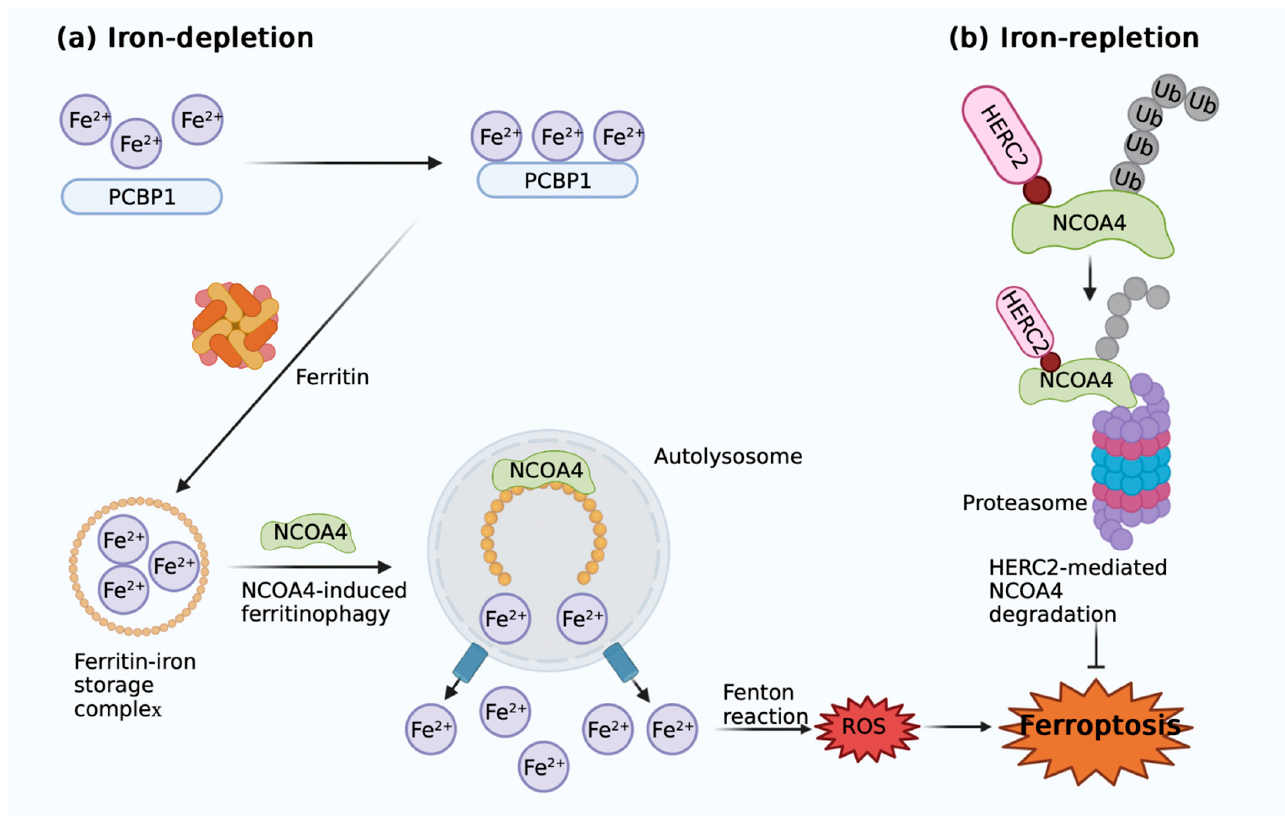
Figure 2. Mechanism of ferritinophagy. ( a ) NCOA4-mediated ferritinophagy promotes ferroptosis induction. NCOA4, coupled with PCBP1, binds to ferritin and mediates its degradation as well as subsequent iron release. ( b ) HERC2 mediates NCOA4 degradation. HERC2 mediates NCOA4 degradation in ubiquitin-dependent ways when iron depletion is present, thereby preventing fer- ritinophagy and ferroptosis. Image was created with BioRender.com (accessed on 25 June 2022). PCBP1: iron chaperones poly rC-binding protein 1; NCOA4: nuclear receptor coactivator 4; ROS: reactive oxygen species; HERC2: homologous to E6AP carboxy terminus (HECT) E3 ubiquitin protein ligase 2; Ub: